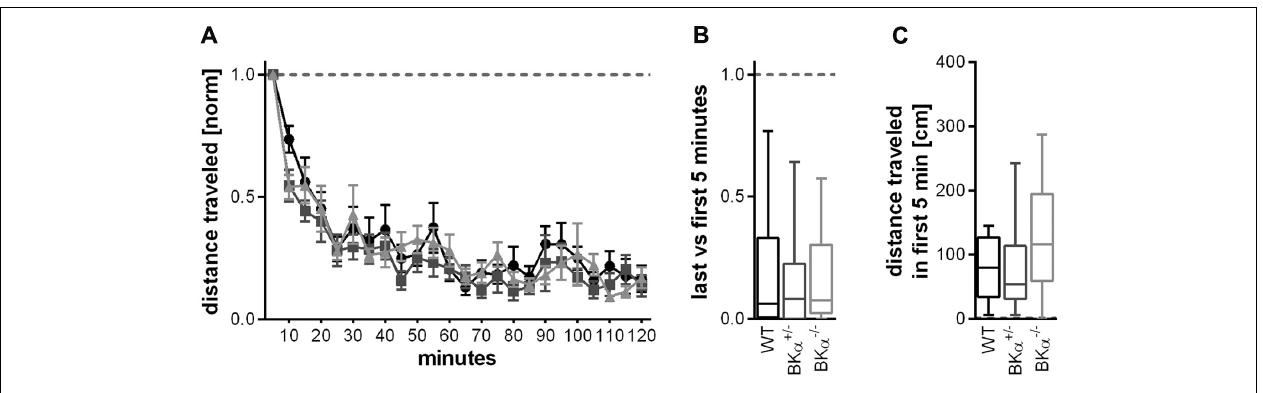
indicating the 5th and 95th percentile of first five versus last five time bins, see Materials and Methods). (C) Distance traveled (median) during the initial 5 min in the locomotor box for all three genotypes. There was no statistically significant difference in general locomotor activity between